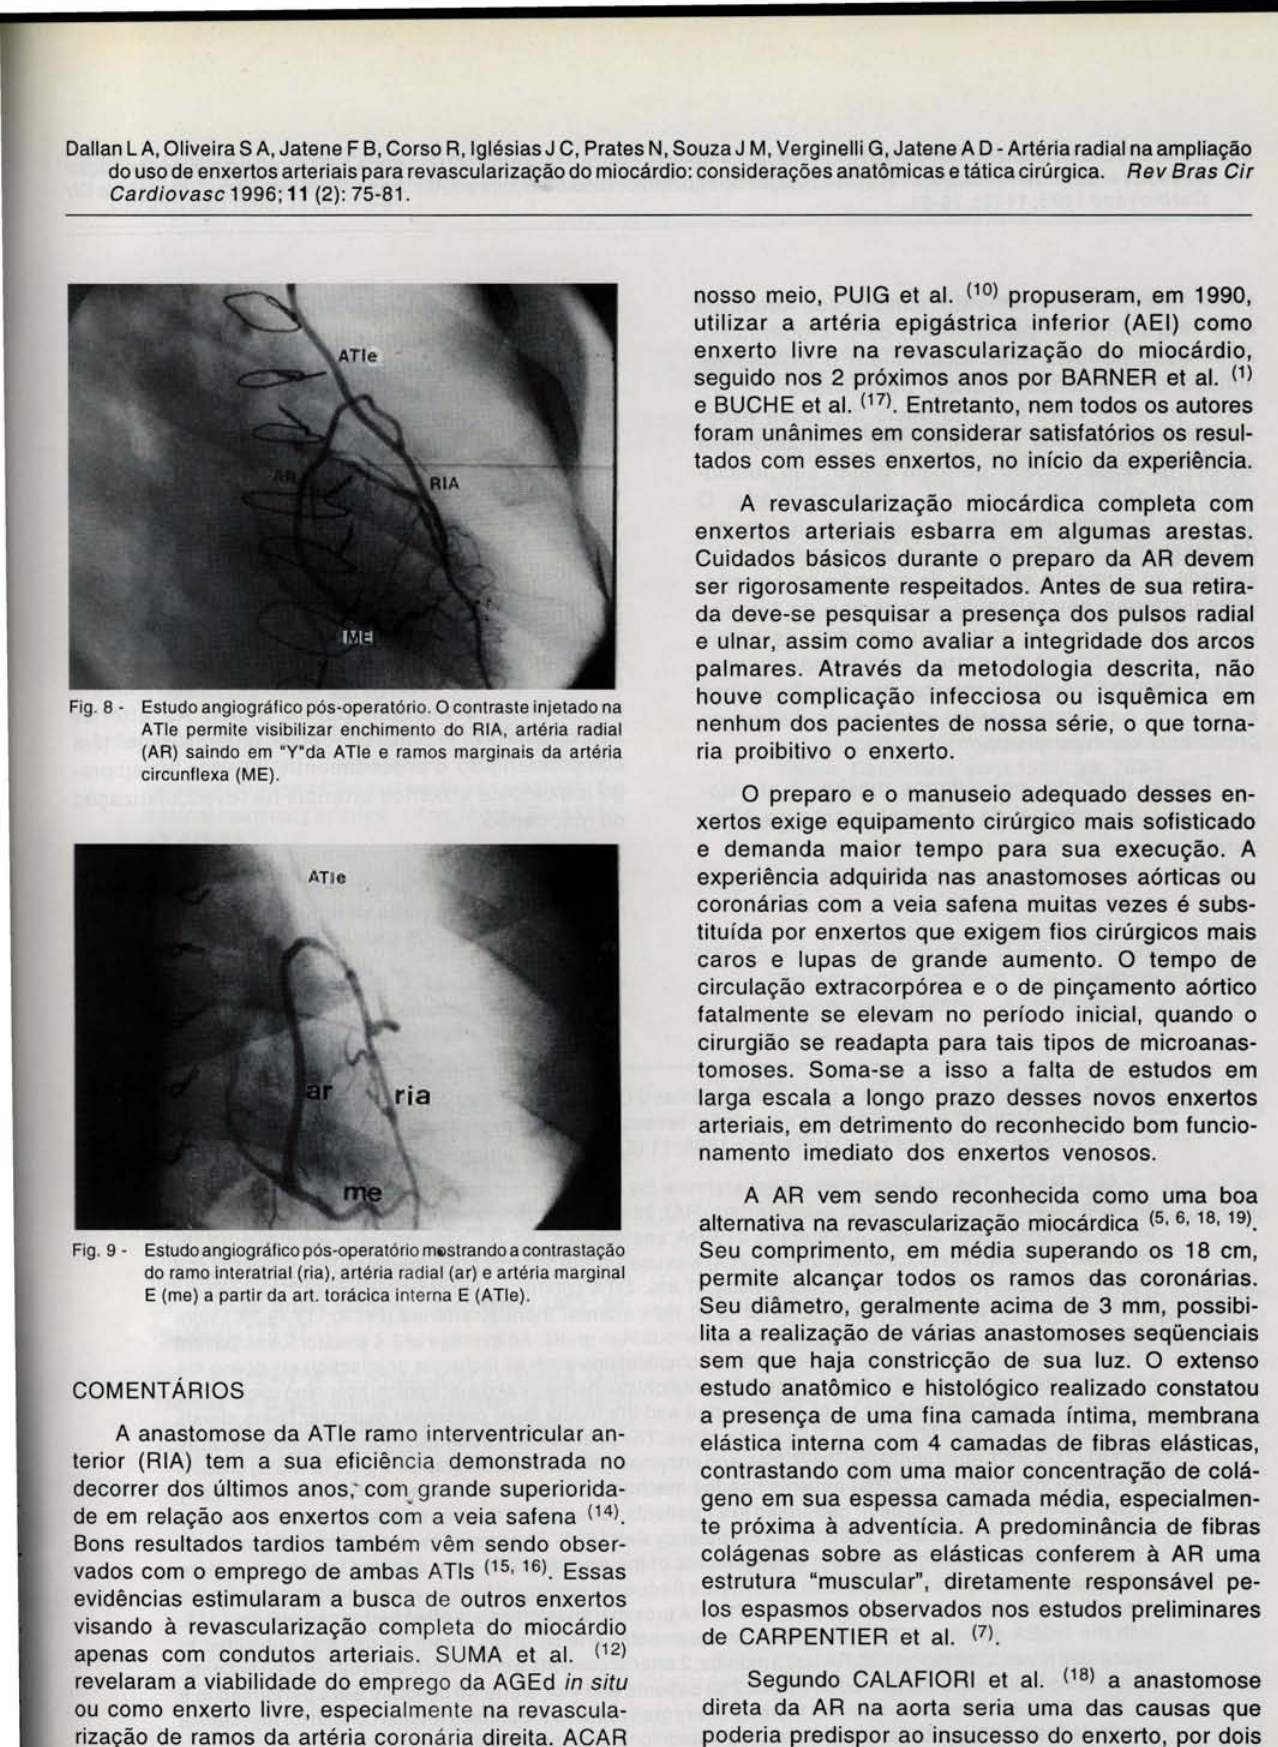
Fig. 9 - Estudo angiográfico pós-operatório m~strando a contrastação do ramo interatrial (ria). artéria radial (ar) e artéria marginal E (me) a partir da arl. torácica interna E